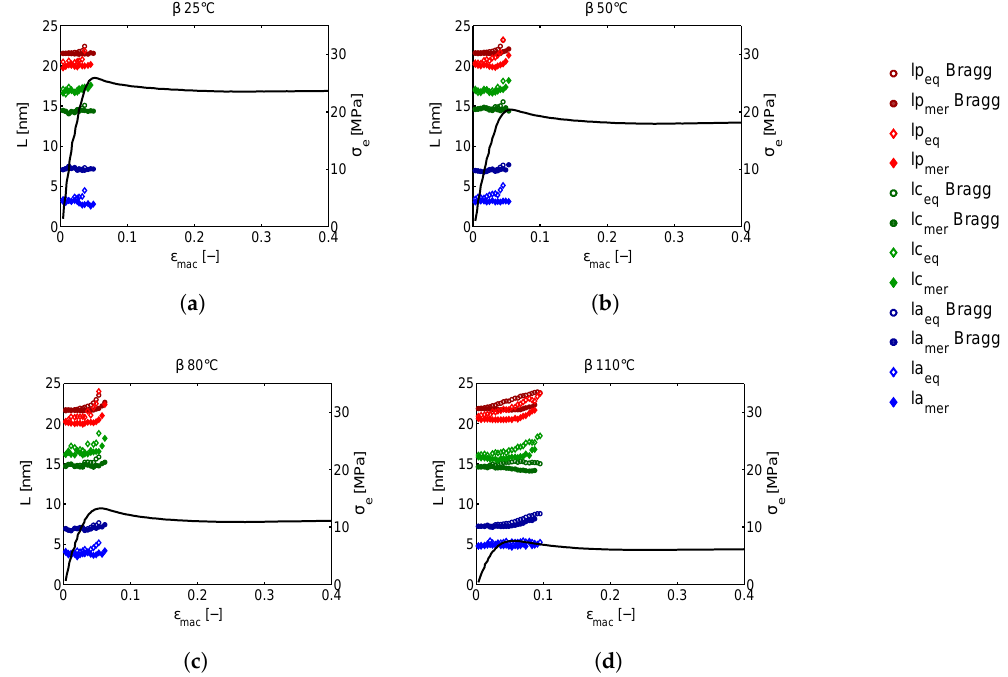
Figure A3. Long period, amorphous layer thickness and lamellar thickness determined via Bragg’s law and the 1D autocorrelation function versus the macroscopic strain for β -iPP, elongated at 25, 50, 80 and 110 ◦